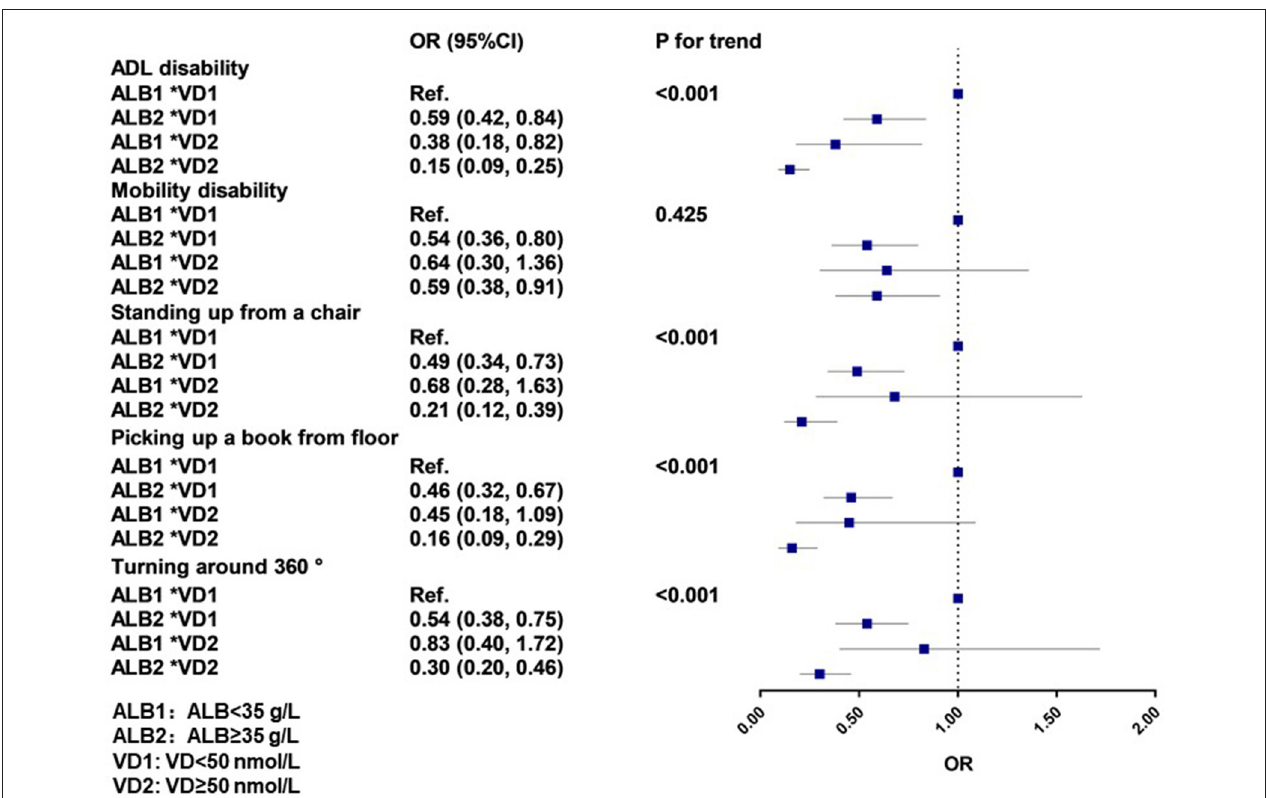
FIGURE 2 | Joint associations of serum albumin level and vitamin D with disability in physical functioning. OR, odds ratio; CI, confidence interval; ALB, albumin; VD, vitamin D; ADL, activities of daily living. The cutoff value was 35 g/L and 50 nmol/L for serum albumin and serum vitamin D level, respectively. ALB1 represents serum albumin levels of the participants were below 35 g/L ( < 35 g/L), ALB2 represents serum albumin levels of the participants were above 35 ( ≥ 35 g/L). VD1 represents the serum vitamin D level of the participants were below 50 ( < 50 nmol/L), VD2 represents the serum vitamin D level of the participants were above 50 ( ≥ 50 nmol/L). In this model, based on model 1, we further adjusted for ethnicity, residence, current marital status, education, lifetime primary occupation, economic independence, being in receipt of adequate medication, co-residence with adult children, currently smoking, currently consuming alcohol, BMI, and regular